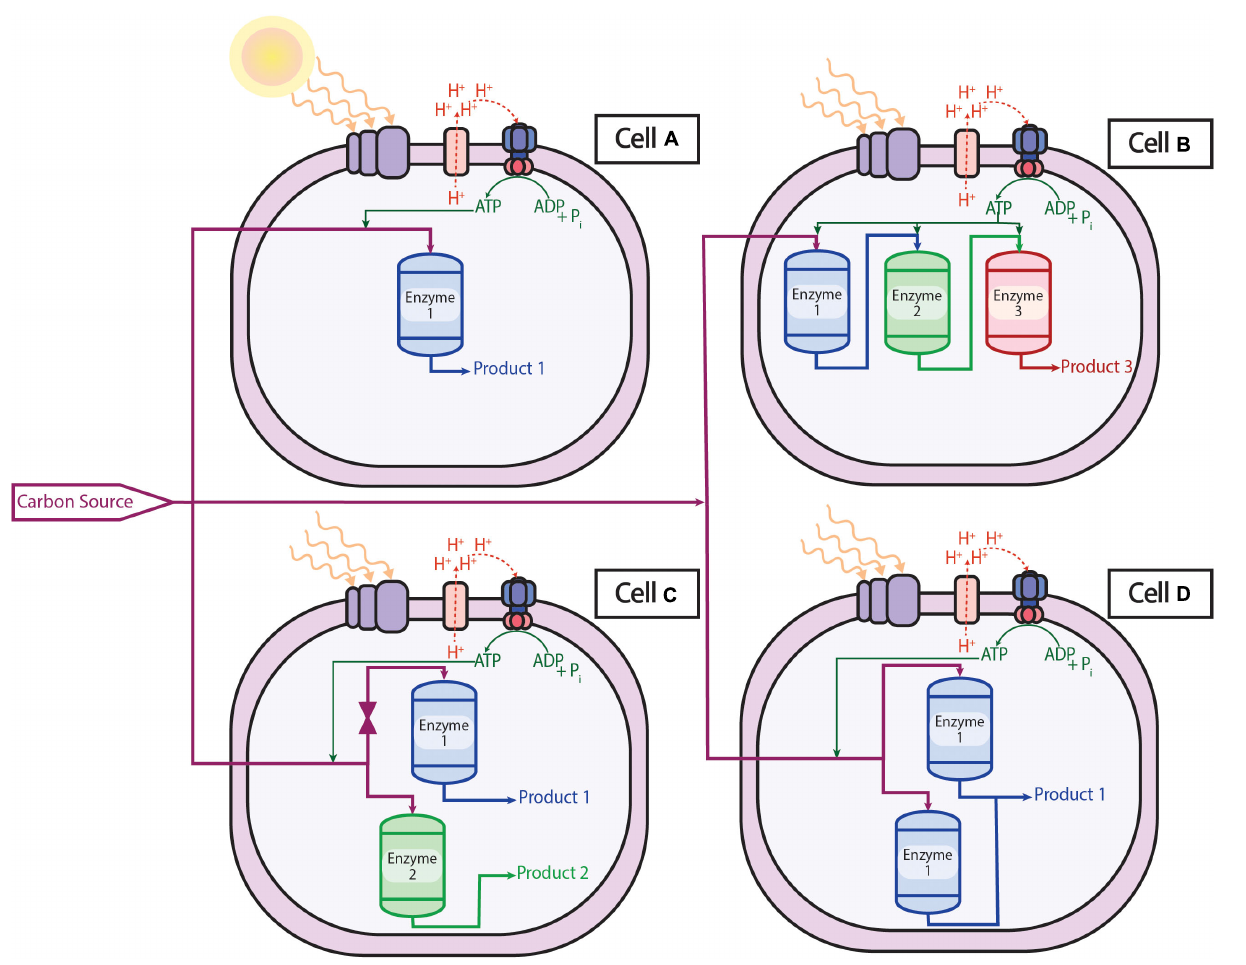
FIGURE 3 | Solar-powered microbial cell factories: Cell A is the wild type organism that takes the carbon source, energy, and electrons and converts them to Product 1 via Enzyme 1. Cell B has had two heterologous enzymes (Enzyme 2 and Enzyme 3) inserted into the cell that produce Product 3 via the original Product 1. Cell C has silenced Enzyme 1 such that no or minimal Product 1 is produced in favor of Product 2 via the inserted non-native Enzyme 2. Cell D has overexpressed Enzyme 1 such that native Product 1 is